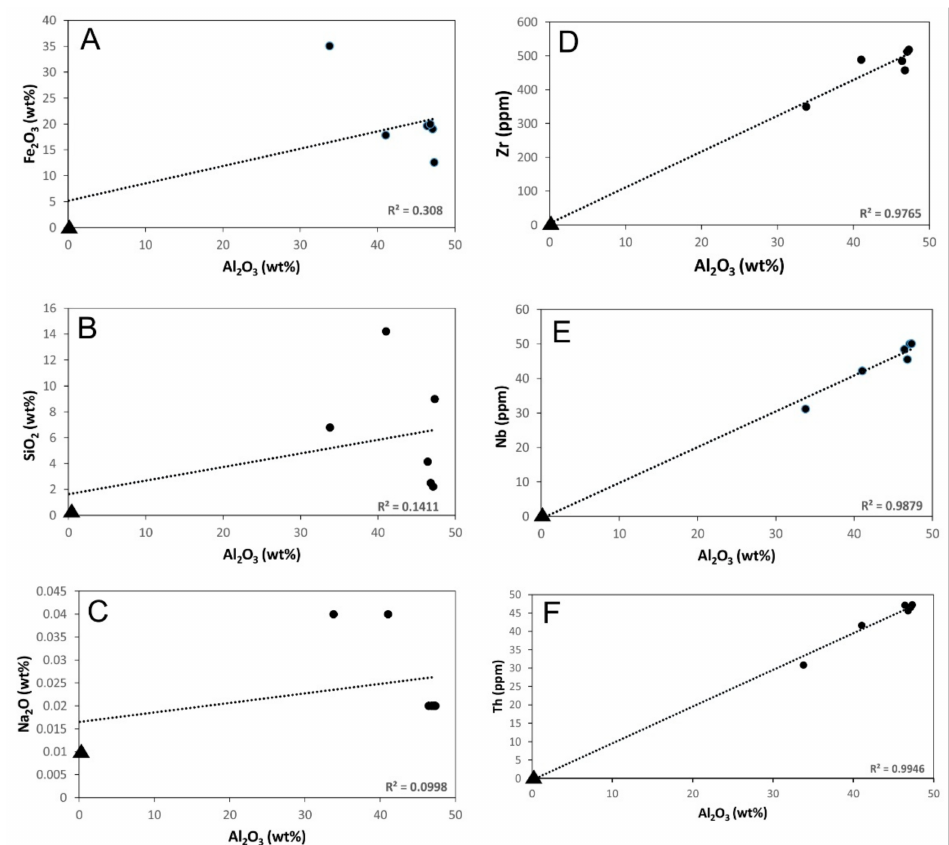
Figure 12. Binary diagrams of major and trace elements vs. Al 2 O 3 in the Toši´ci-Duji´ci bauxite samples ( • ) and footwall limestone ( (cid:78) ). Immobile elements are well correlated with Al 2 O 3 having values R 2 > 0.9 ( A )—Al 2 O 3 vs. Fe 2 O 3 , ( B )—Al 2 O 3 vs. SiO 2 , ( C )—Al 2 O 3 vs. Na 2 O, ( D )—Al 2 O 3 vs. Zr, ( E )—Al 2 O 3 vs. Nb, ( F )—Al 2 O 3 vs.